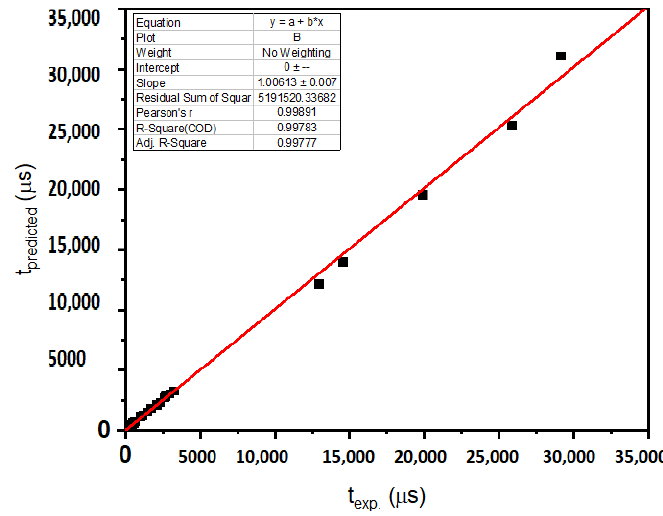
Figure 7. Experimentally estimated lifetime t against predicted utilizing ANN.